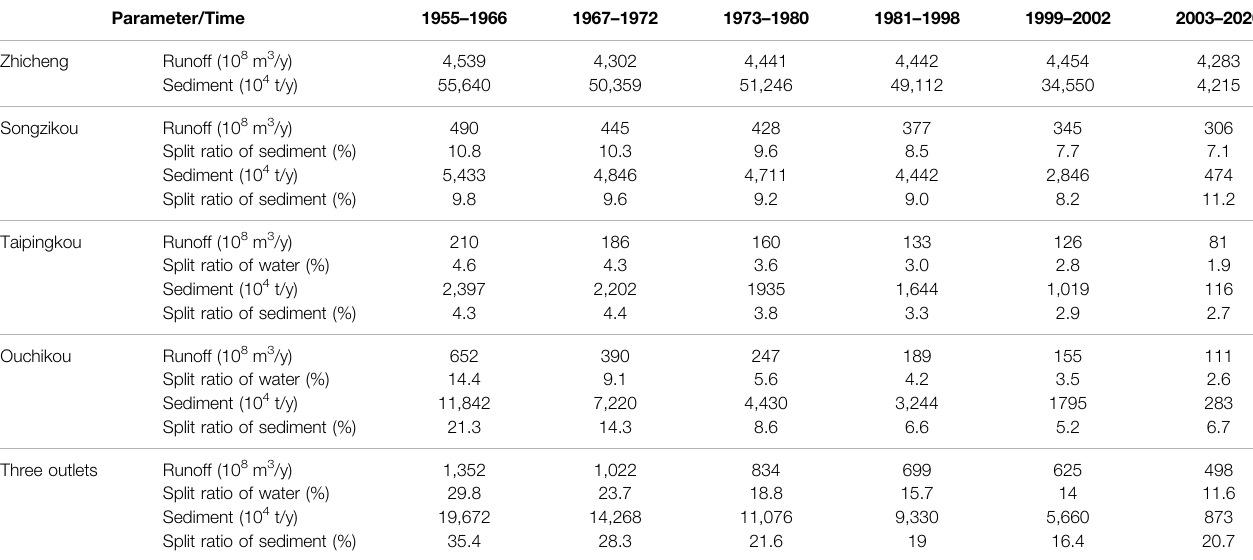
TABLE 2 | Runoff and sediment quantity, split ratio of water and the sedimentof the three outlets of Dongting